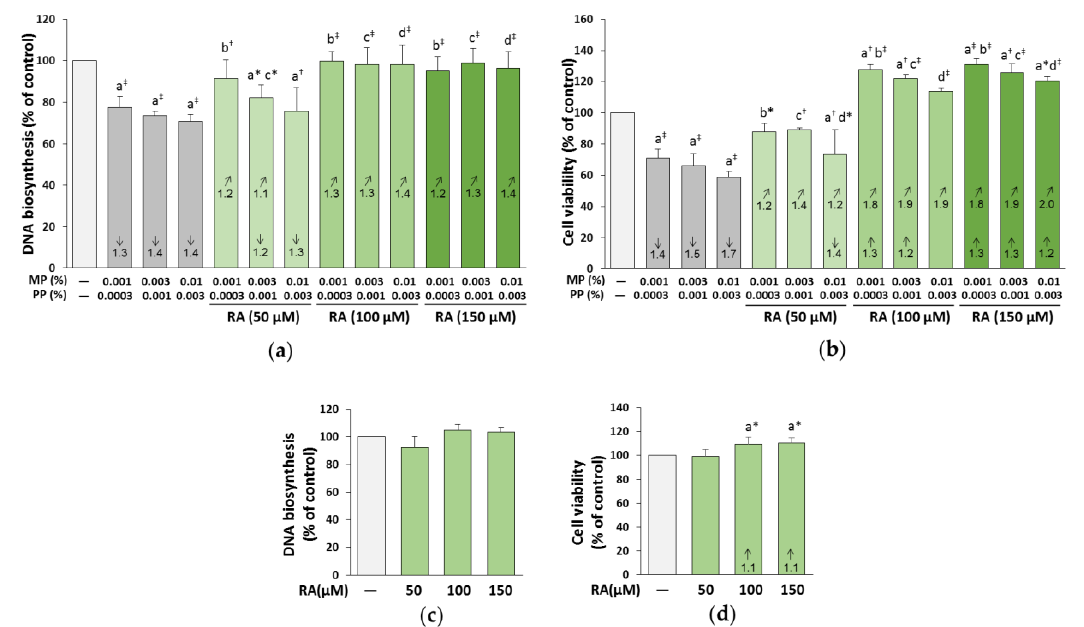
Figure 11. The influence of rosmarinic acid (RA) on the proliferation ( a , c ) and the viability ( b , d ) of the fibroblasts treated with methylparaben (MP) and n-propylparaben (PP) ( a , b ), and untreated cells ( c , d ). Values represent the mean ± SD of three experiments done in duplicate. Statistically significant differences are marked as: a vs. control, b vs. 0.001% MP and 0.0003% PP, c vs. 0.003% MP and 0.001% PP, d vs. 0.01% MP and 0.003% PP; * p < 0.05; † p < 0.01; ‡ p < 0.001. The values in the bars show a factor of change in comparison to the control ( ↑ , increase; ↓ , decrease) or to the respective samples treated with parabens alone (MP and PP) ( ↗ , increase).